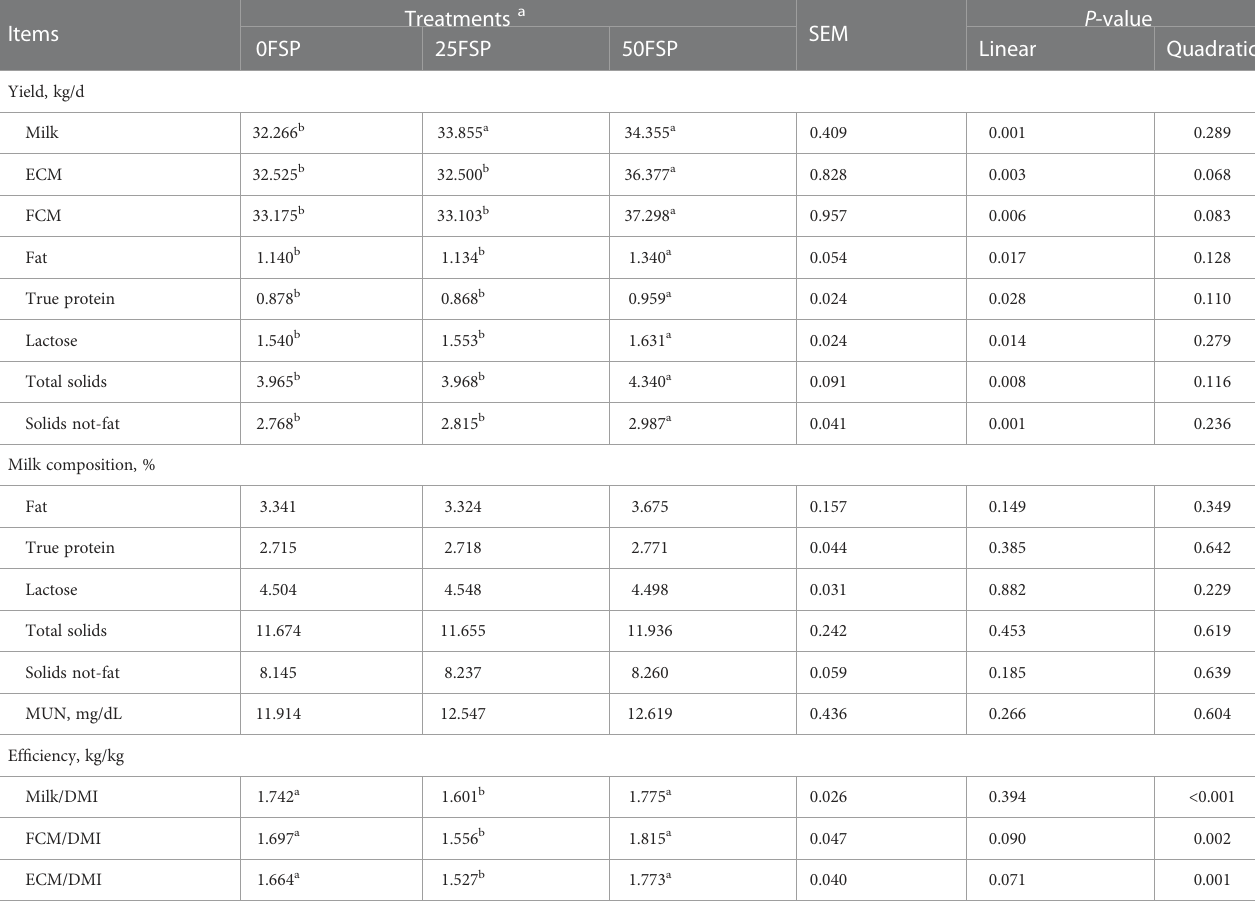
TABLE 5 Milk yield and composition of early lactating Holstein dairy cows (n = 8 per treatment) fed a basal diet supplemented with fennel seed powder